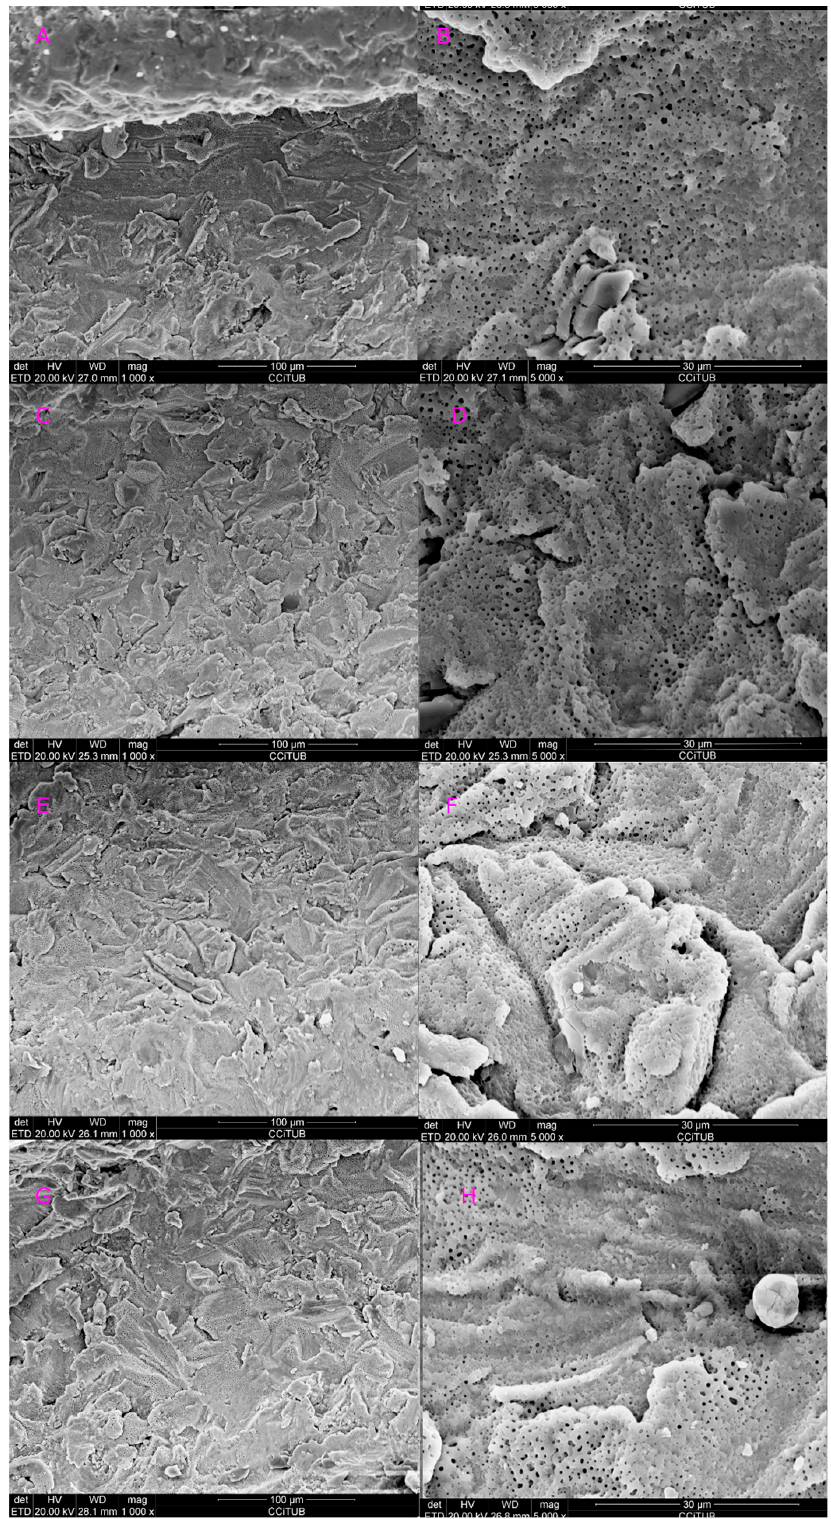
Figure 3. Control versus all 3 tips at 1.5 W. ( A ) Control at 1000× magnification; ( B ) control at 5000× magnification; ( C ) conical tip (RTF3-17 mm) at 1000× magnification; ( D ) conical tip (RTF3-17 mm) at 5000× magnification; ( E ) side firing tip (SFT8-18 mm) at 1000× magnification; ( F ) side firing tip (SFT8-18 mm) at 5000× magnification; ( G ) cylindrical (MGG6-6 mm) tip at 1000× magnification; ( H ) cylindrical (MGG6-6 mm) tip at 5000× magnification.